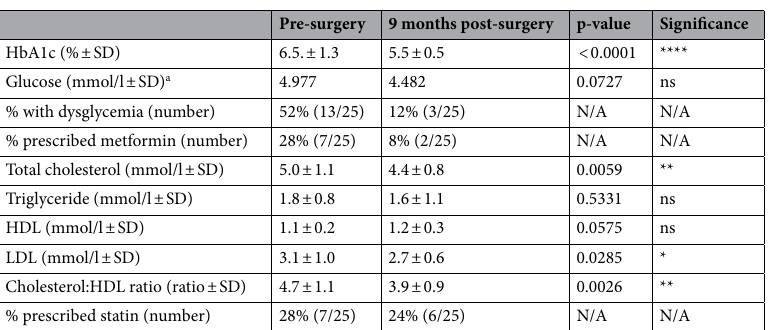
Table 2. Mean HbA1c, glucose total cholesterol, triglyceride, HDL and LDL concentrations and prescribed medications in participants before and 9 months after bariatric surgery. The p-values were calculated using paired T-test. Statistical significance is indicated as: ns not significant (p > 0.05), *p ≤ 0.05 and **p ≤ 0.01, ***p ≤ 0.001 and ****p ≤ 0.0001. N/A for not applicable. a Measurements of blood glucose conc. before and after surgery were only available in 22 of the 25